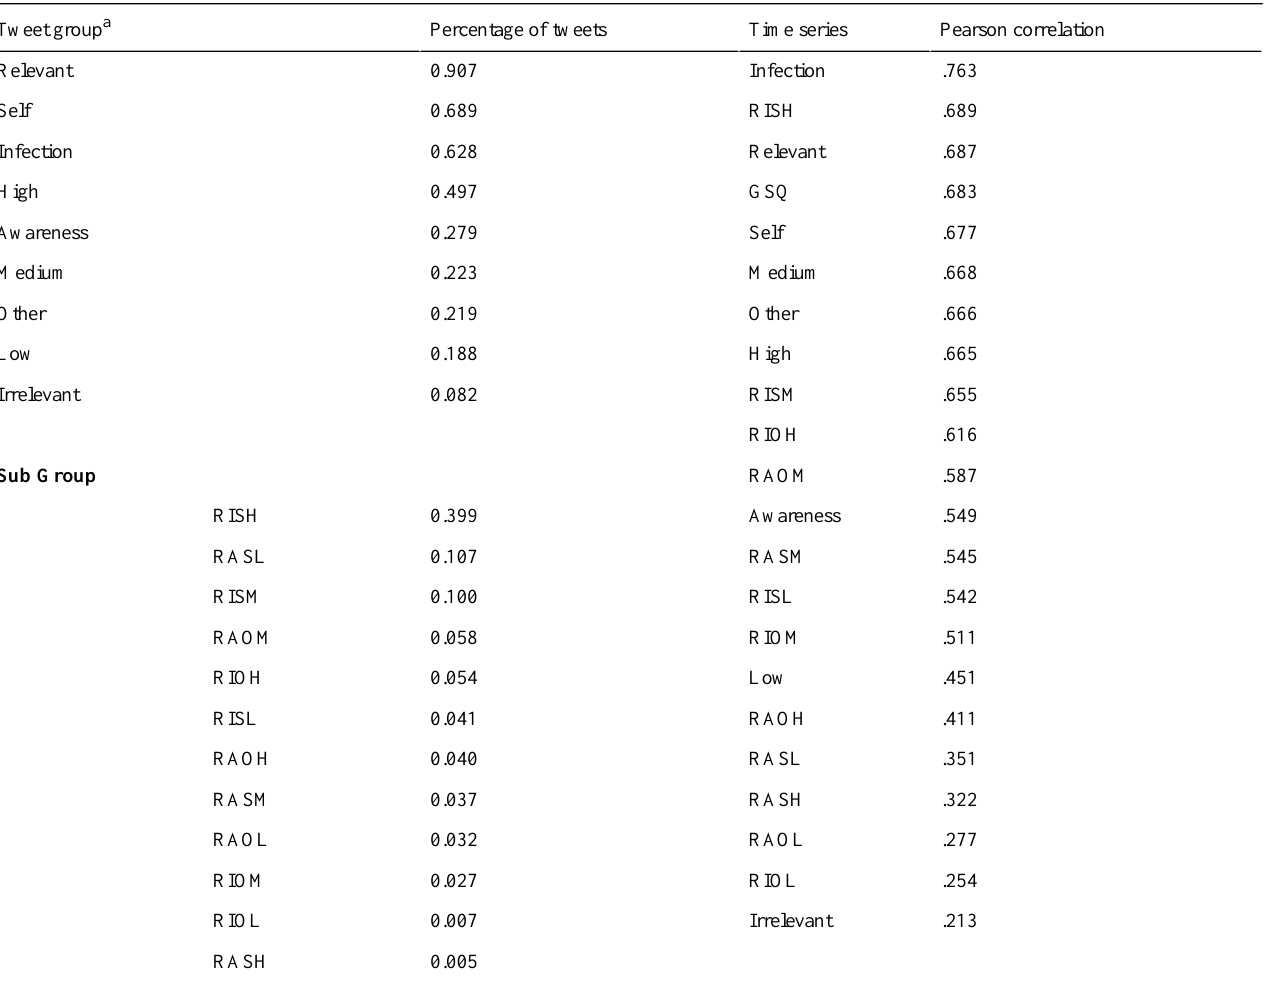
Table 1. Quality of the classified tweets and search query